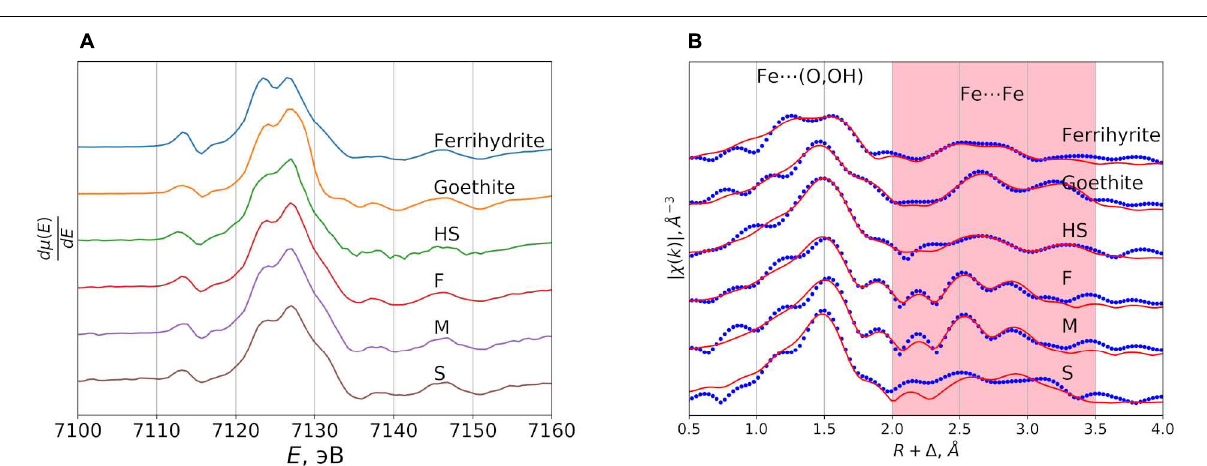
FIGURE 4 | The first derivatives of the XANES spectra shown in Supplementary Figure SM7 (A) and the results of model approximation of the EXAFS spectra in R-space (B) for the 57 Fe-labeled nanofertilizer samples under